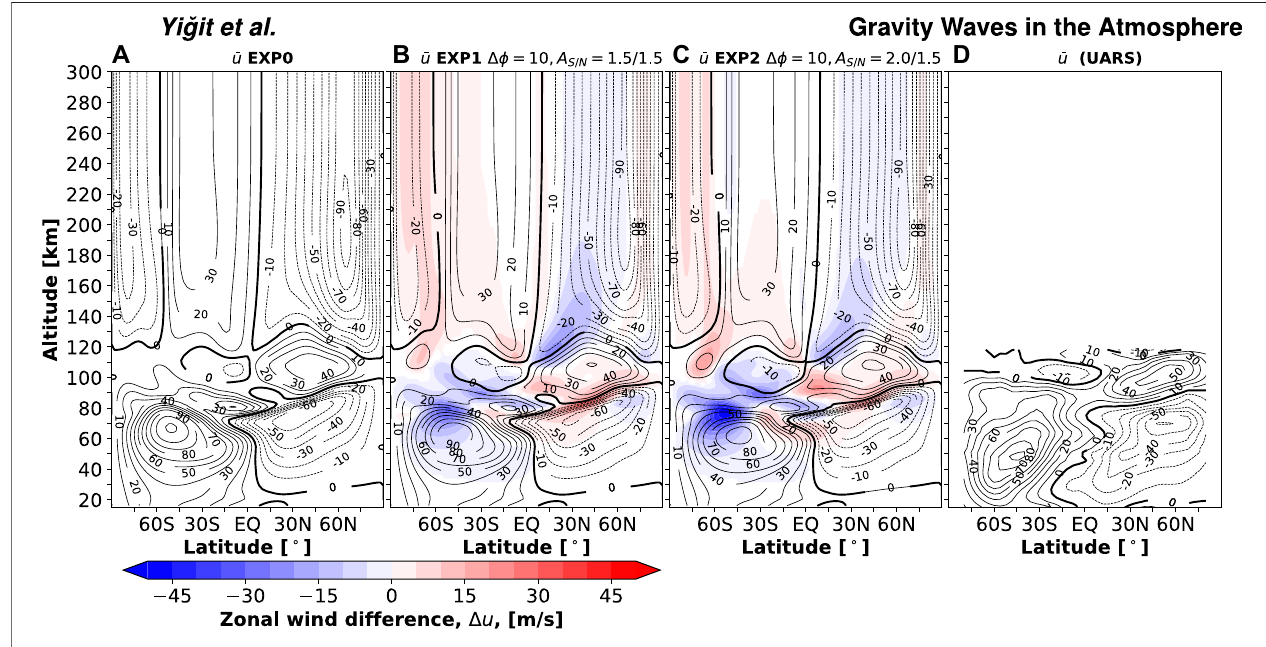
FIGURE 4 | Zonal mean winds (black contours) and differences (color shading) for the 2010 June-July period: (A) EXP0: benchmark simulation; (B) EXP1: using sinusoidally varying GW spectrum with a factor of 1.5 enhancement of the peak horizontal momentum fl ux in both hemispheres and a southward latitudinal shift of 10 ° with respect to EXP0; (C) EXP2: the same as EXP1 but with a factor of 2 enhancement in the SH; (D) UARS winds. The contour intervals for the zonal winds and wind differences are 10 m s − 1 and 5 m s − 1 , correspondingly. Thedifferences between agiven run (EXP1 or EXP2) and the benchmark run (EXP0) areshown, i.e., EXP1- EXP0 and EXP2-EXP0.